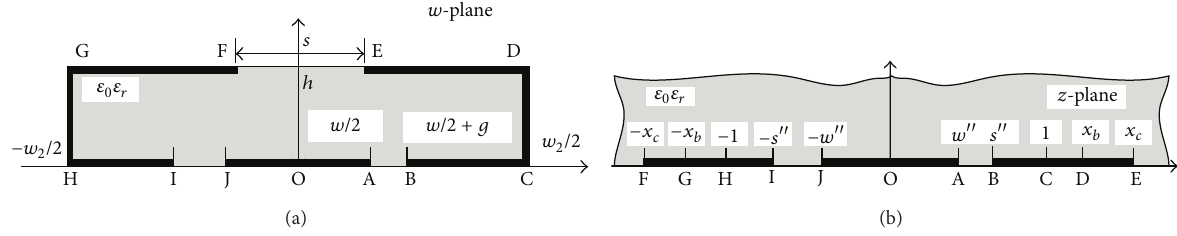
Figure 7: Conformal mapping transformation for Region